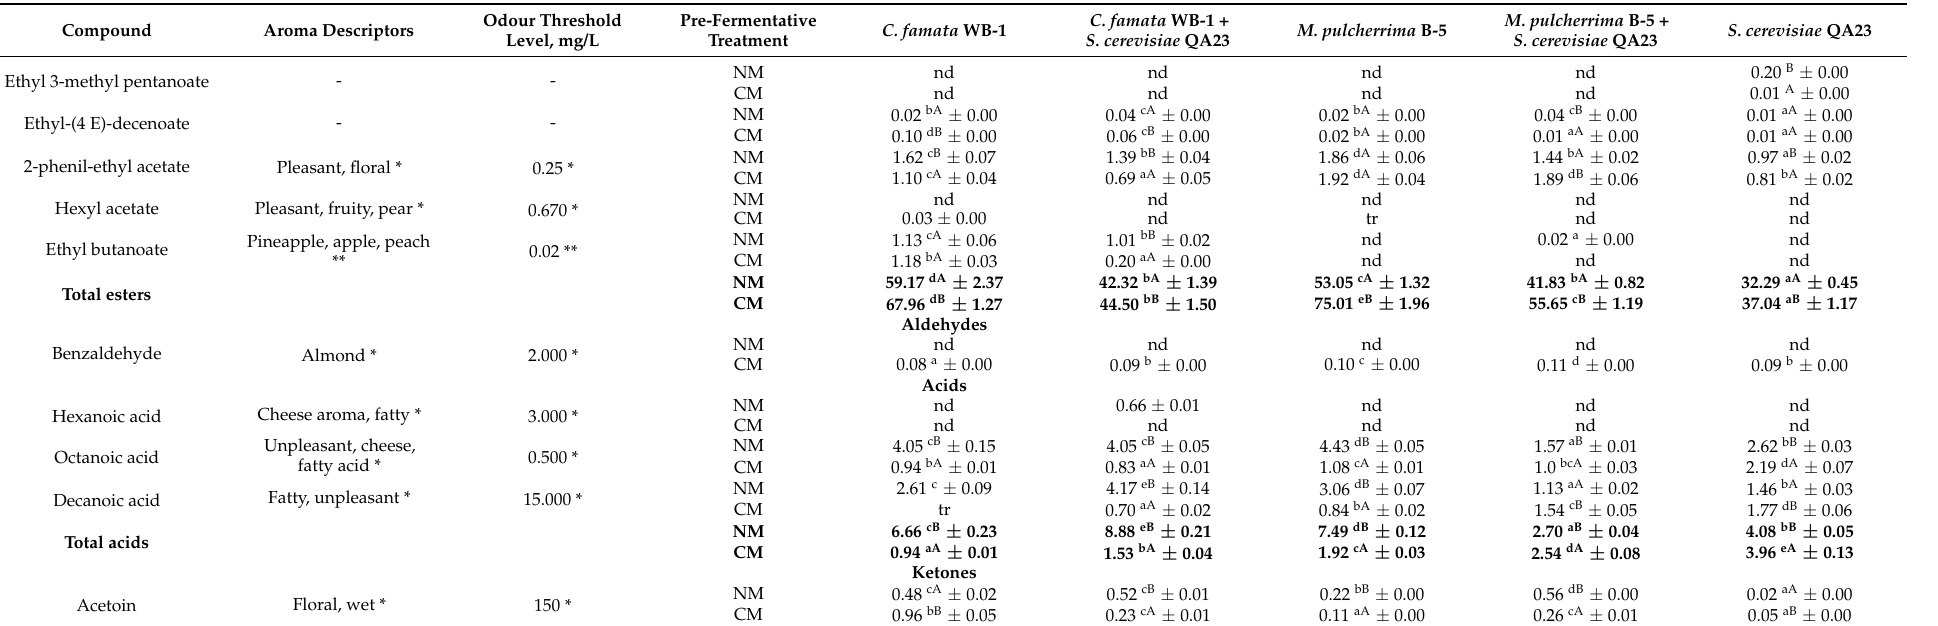
Table 2. Content of volatile compounds (mg/L) in wines produced with and without